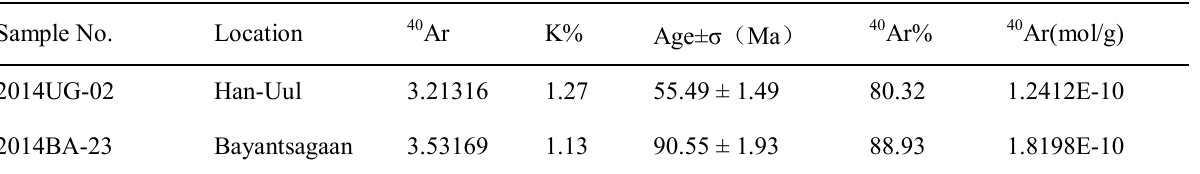
Table 1. Whole rock K-Ar dating result of Bayantsagaan and Han-Uul volcanic rocks from South Mongolia Sample No.